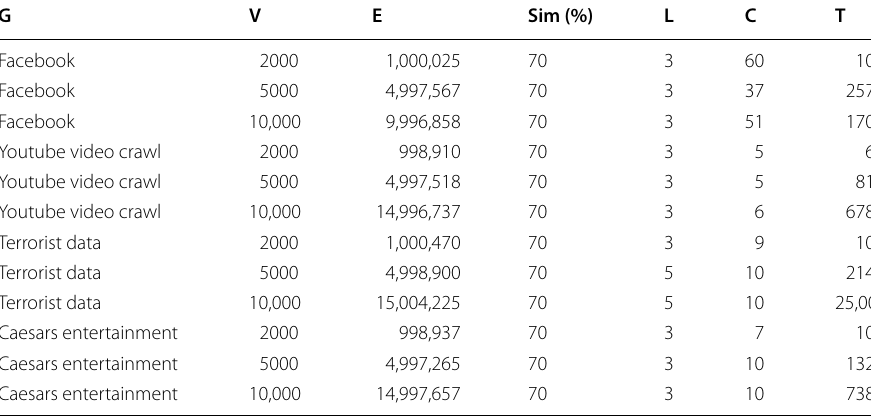
Table 10 Experimental results on large